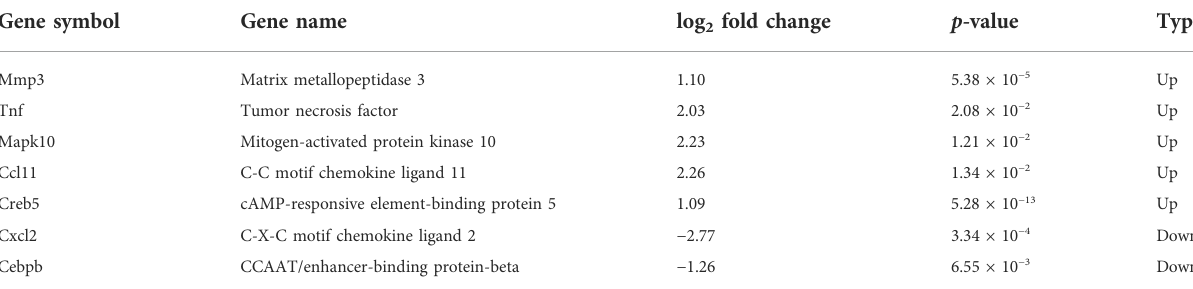
TABLE 1 Differentially expressed genes enriched in the IL-17 and TNF and signaling